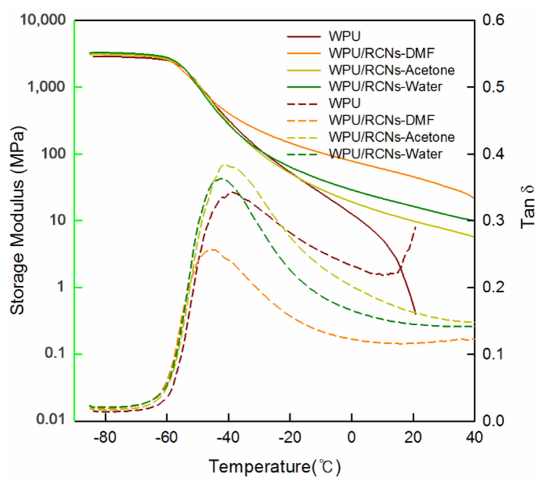
Figure 6. DMA properties curves of WPU, RCNs/WPU nanocomposites films. Thermal properties: Figure 7 shows the TGA curves for WPU, RCNs and RCNs/WPU